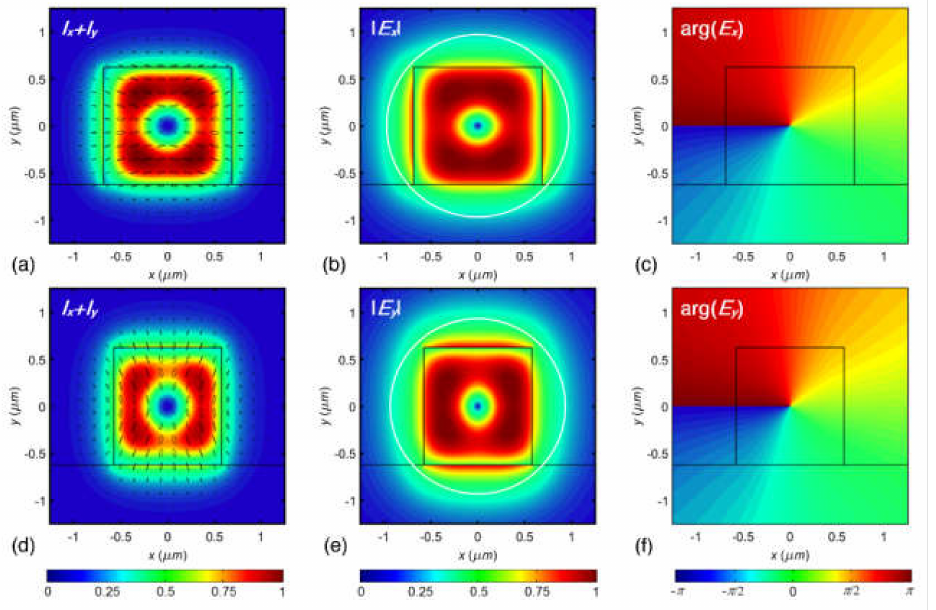
Figure 11. The normalized transversal field component intensity distribution superimposed with polarization map ( a , d ) [166], Normalized absolute amplitude mapping of dominant E-field com- ponent ( b , e ) and phase distribution of dominant E-field component ( c , f ) of the quasi-TE ( a – c ) and quasi-TM ( d – f ) quasi-degenerate modes of order l = 1 in the symmetric (silica clad) silicon nitride WGs enhanced for phase-matched propagation of the constituent eigenmodes ( β 01 ≈ β 10 )